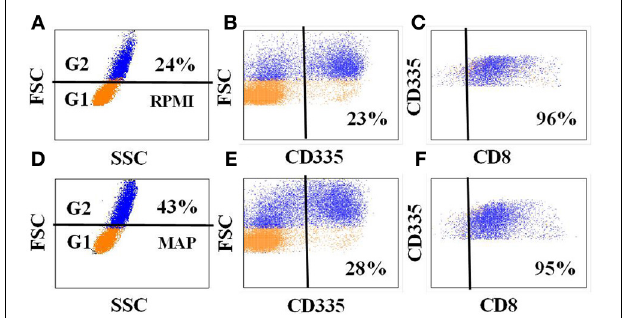
FIGURE 5 | Expression of CD8 on NK cells in PBMC from Map infected animals. Data show the expression of CD8 on NK cells in PBMC cultured in medium alone (A–C) and in the presence of Map (D–F) . An additional gate was placed on NK cells to show co-expression of CD8 (C,F) .